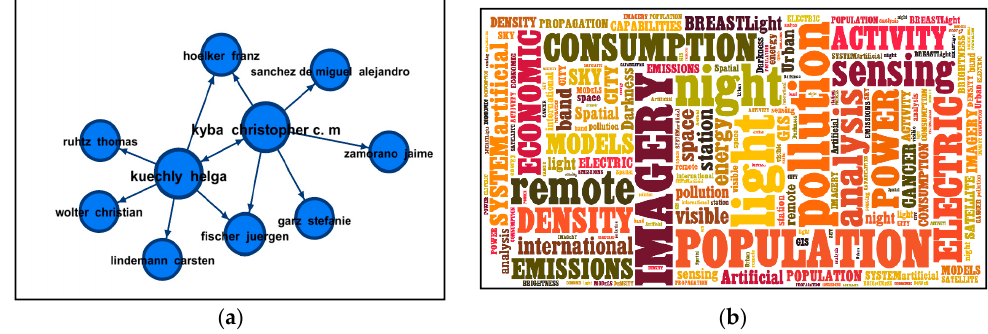
Figure 8. Kyba, C.–Kuechly, H. research community: ( a ) co-author network; ( b ) related topics.